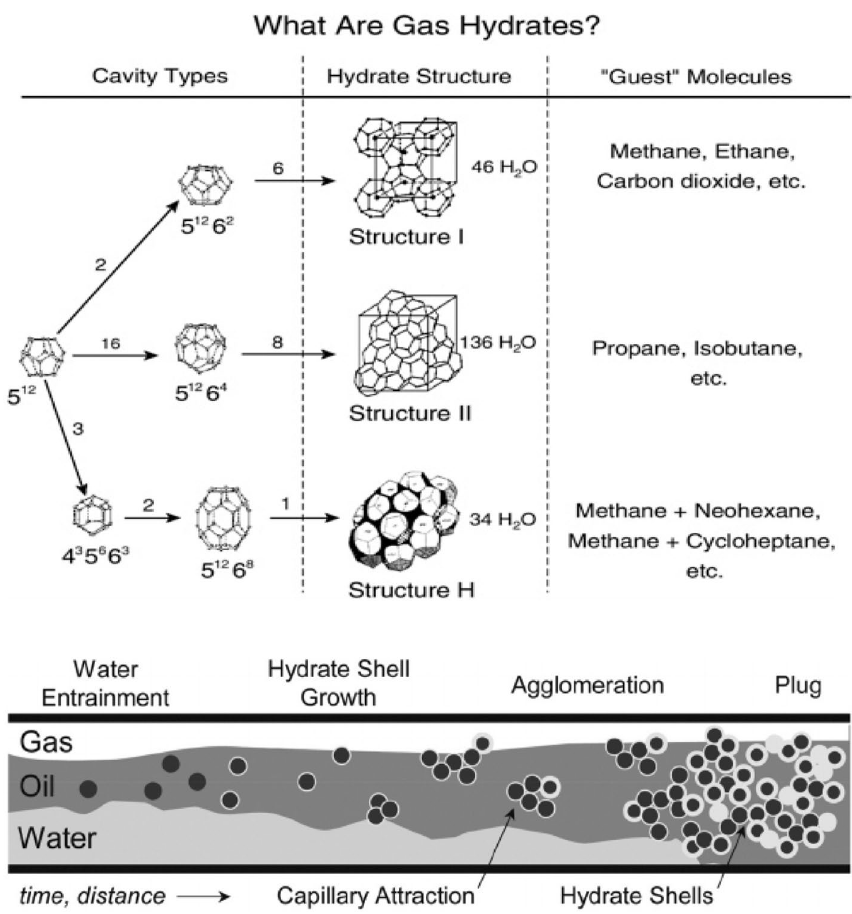
Fig. 1 Gas hydrates structures (Processors et al. 1967)